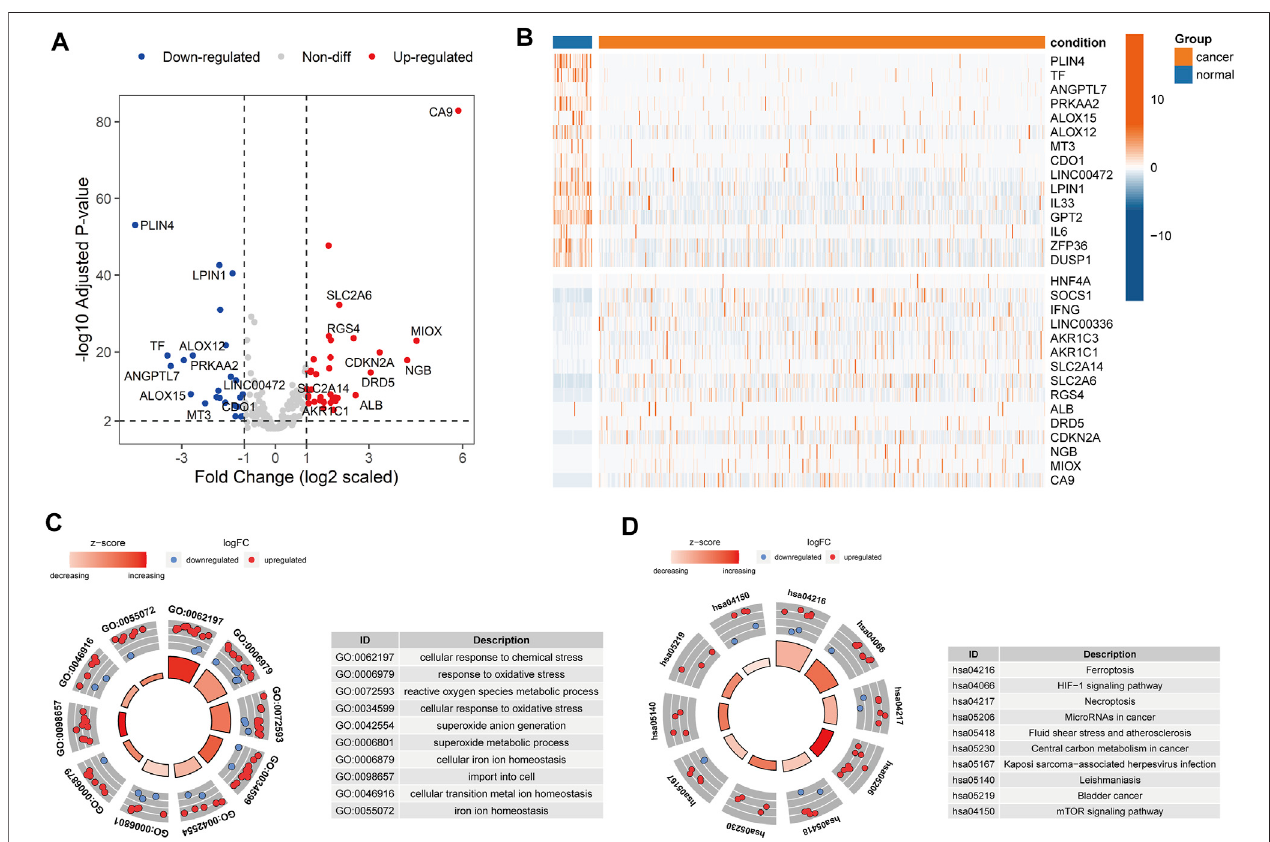
FIGURE 1 | Dysregulated ferroptosis-related genes in HNSCC. (A) Volcano plot showing the differentially expressed FEGs between cancer and normal samples. Red and blue dots represent the up and downregulated FEGs, respectively. (B) Heatmap showing the top 15 up and downregulated FEGs between cancer and normal samples. C-D. Circle plotshowing thez-scoreofsigni fi cantlyenriched (C) GO terms and (D) KEGG pathways. Red dots indicated upregulation,whiletheblue indicated downregulation. The Z-score was calculated by the R package “ GOplot ” . The signi fi cantly enriched GO terms and KEGG pathways are listed on the left.